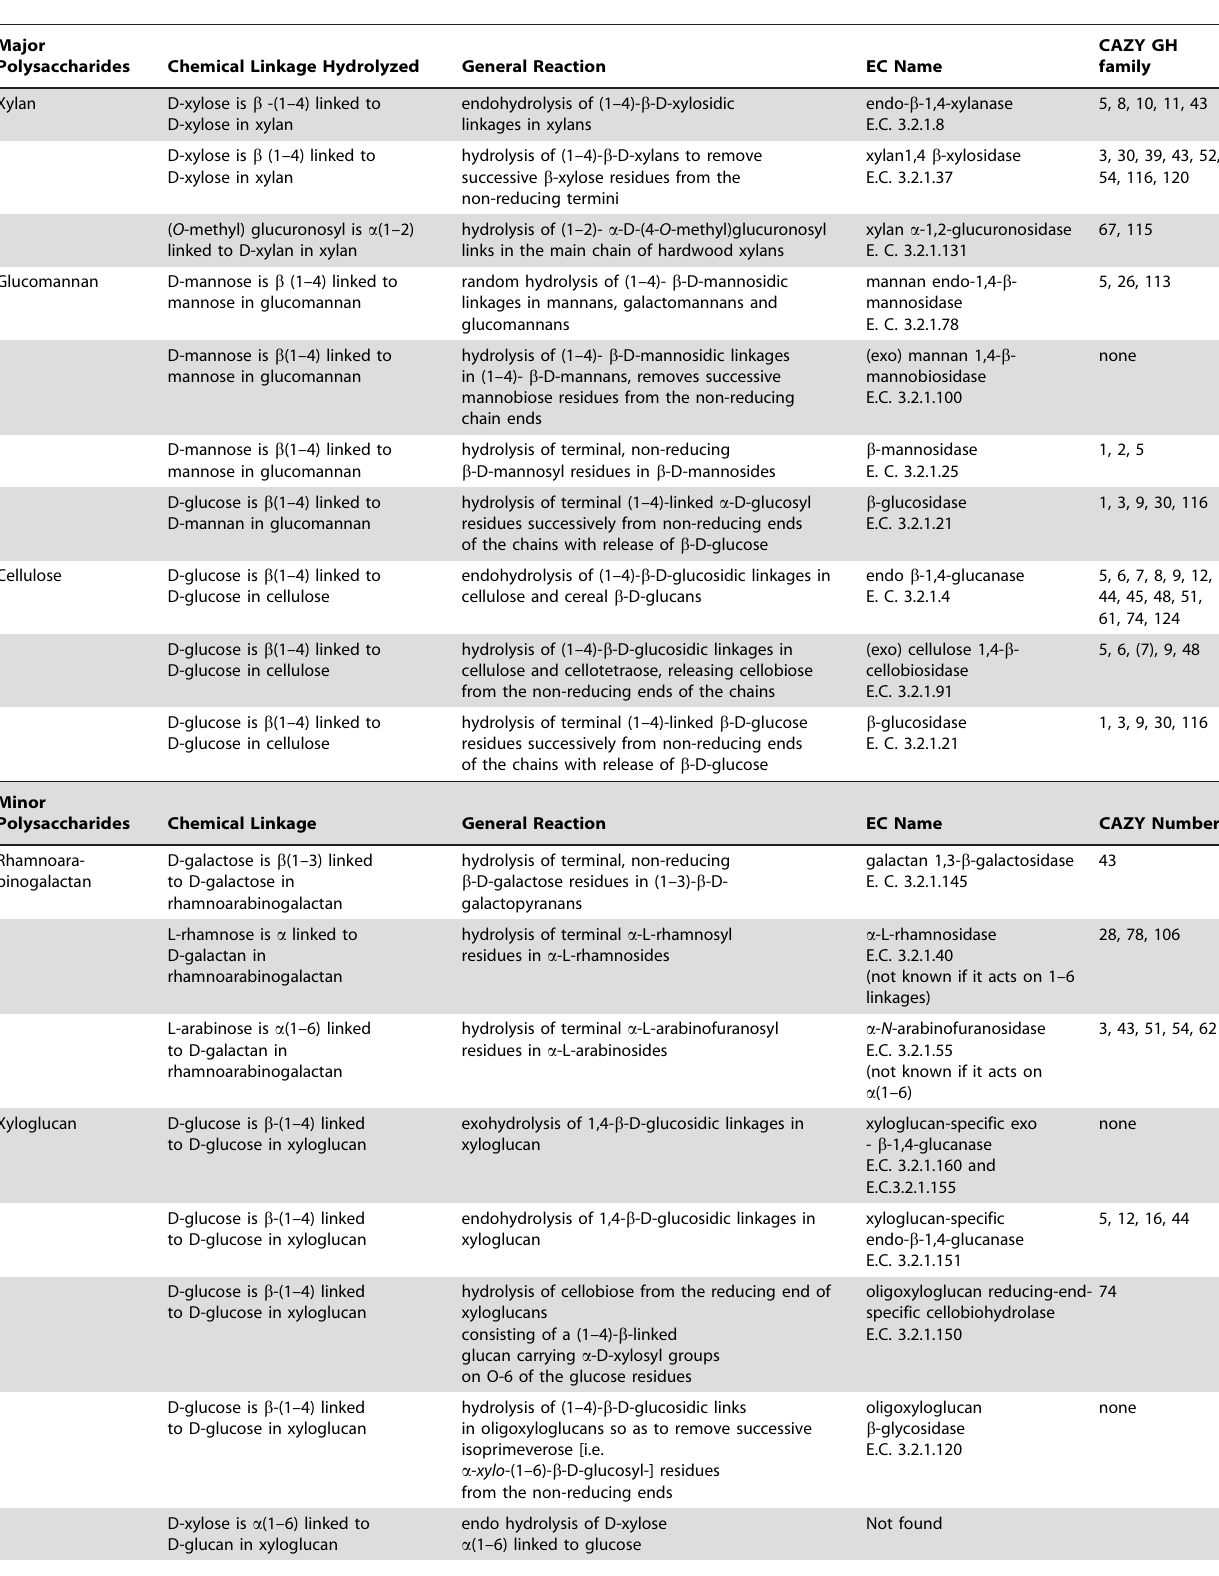
Table 4. Overview of the critical polysaccharide bonds in found in poplar hardwood as well as the glycoside hydrolases that act on these